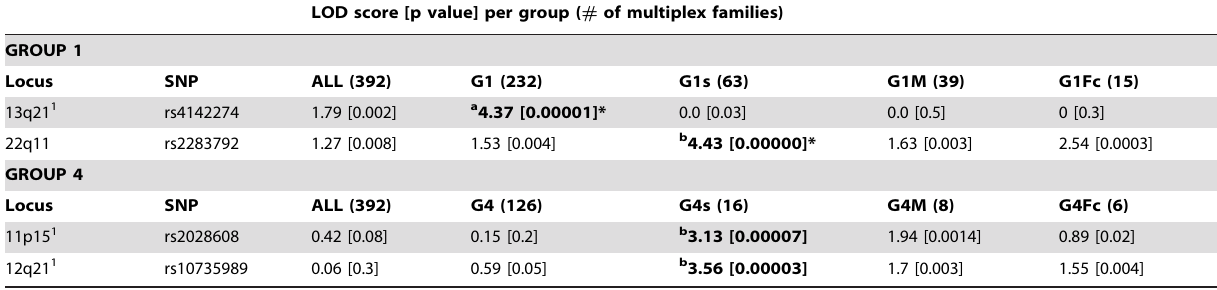
Table 2. Loci with highest LOD scores for a given